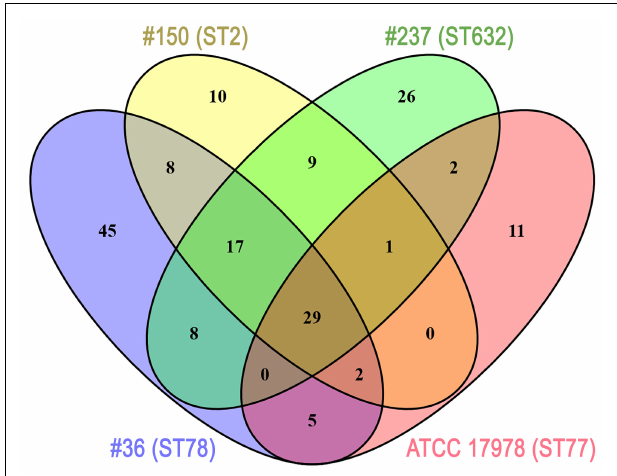
FIGURE 2 | Venn diagram showing the number of proteins shared among A. baumannii strains. Each A. baumannii isolate is depicted by a different oval color, as indicated. Proteins included were those identified by MS (cut-off: protein confidence = 95%) in the 20–36 kDa range from the Coomassie-stained gel shown in Figure 1 , and having at least 95% = 4 minimum peptides. Numbers in the non-overlapping regions show the number of proteins unique to that strain. Supplementary Table S2 contains the information shown in this diagram at the protein level.